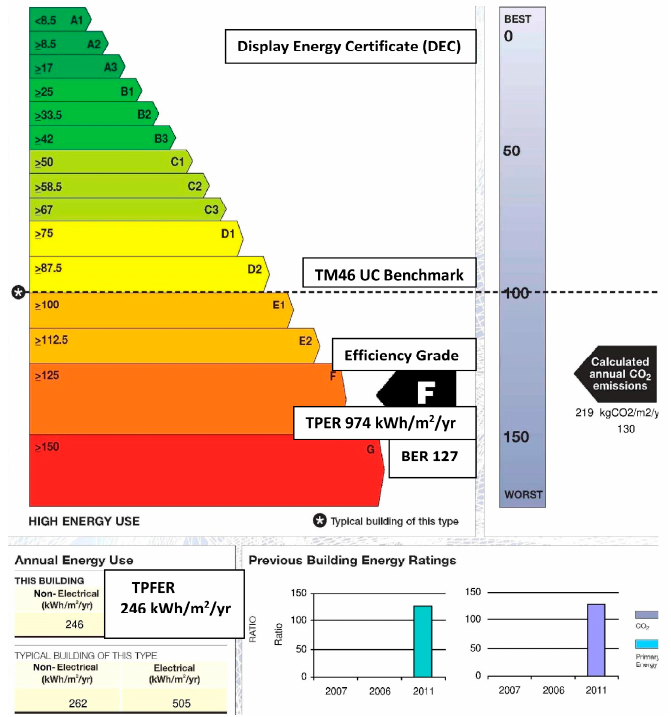
Figure 1. The main data presented on a display energy certificate (DEC).